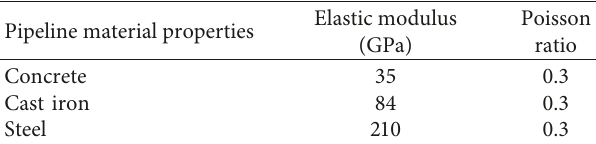
Table 2: Summary of the material properties of the pipeline.